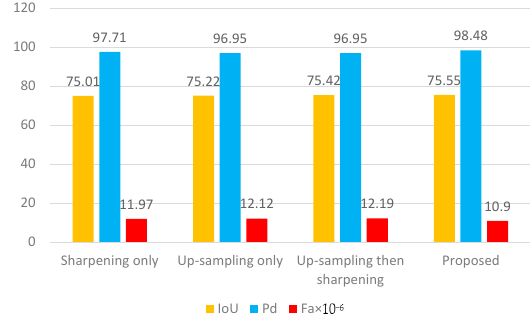
Figure 15. Ablation